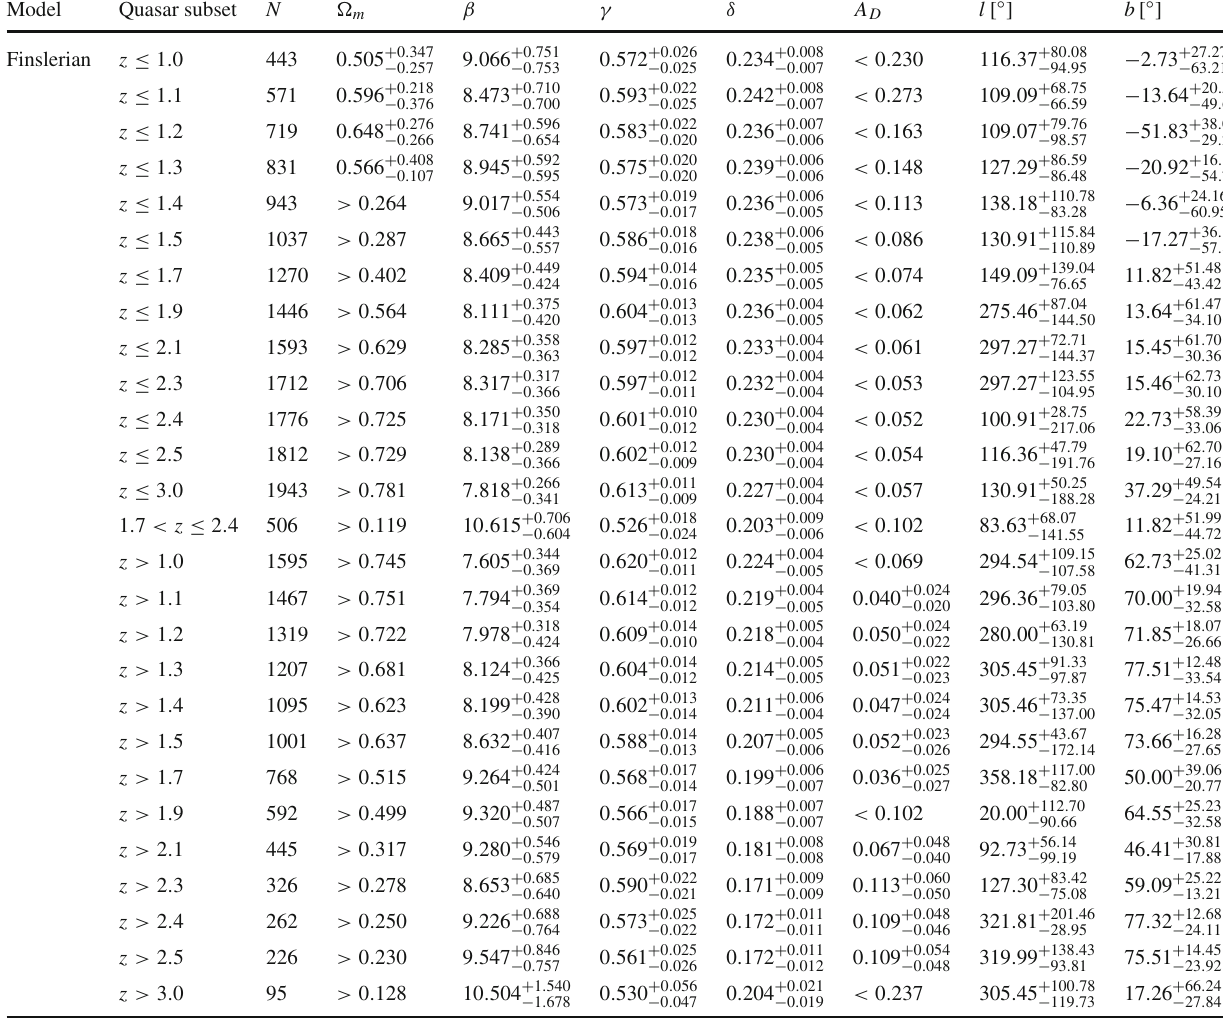
Table 2 The 68% confidence level constraints of the parameters in the Finslerian cosmological model with different cutting redshifts. If the upper or lower limit of a parameter exists, we show the 95% confidence level of the parameter